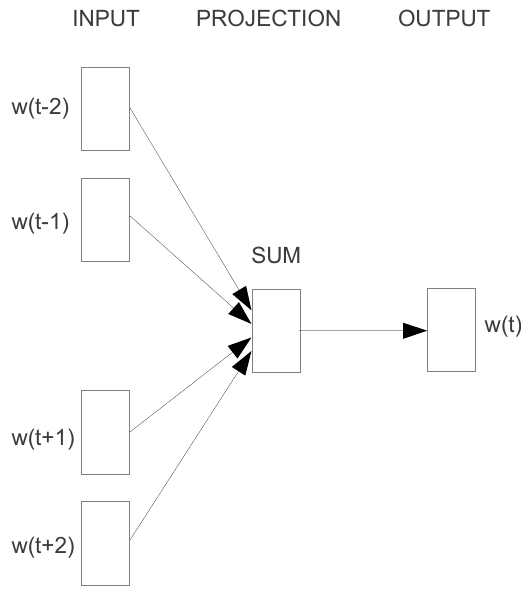
Figure 3. The framework of the classical CBOW